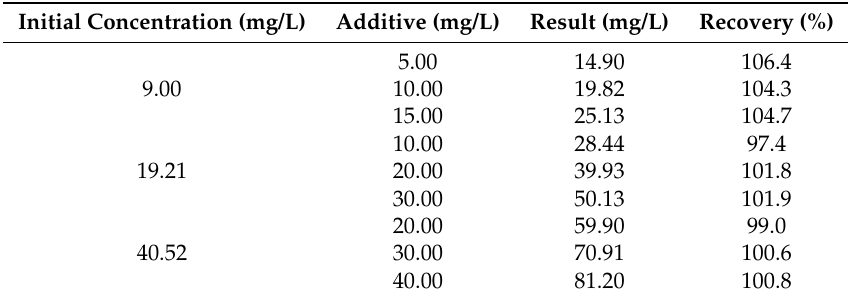
Table 3. Recovery of nano-Al 2 O 3 by UV spectrophotometry.